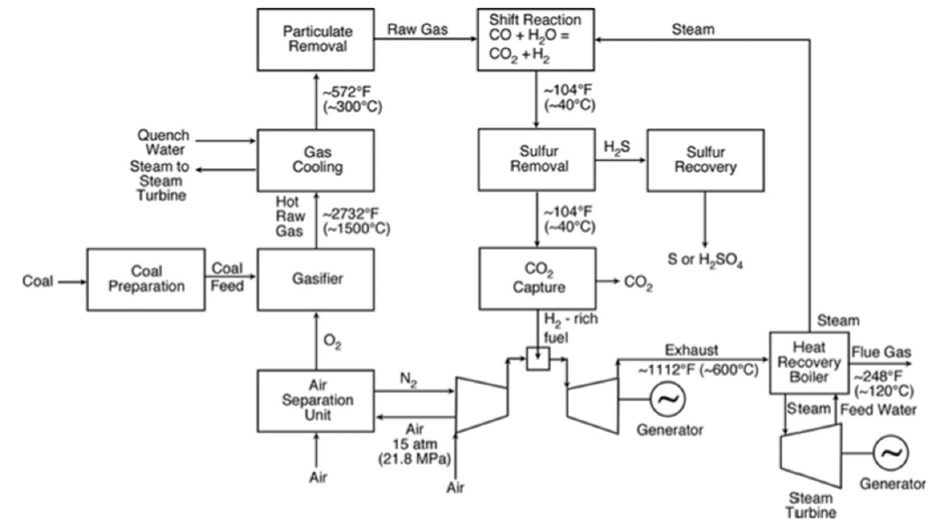
Figure 2. A schematic layout of an IGCC power plant using pre combustion carbon capture